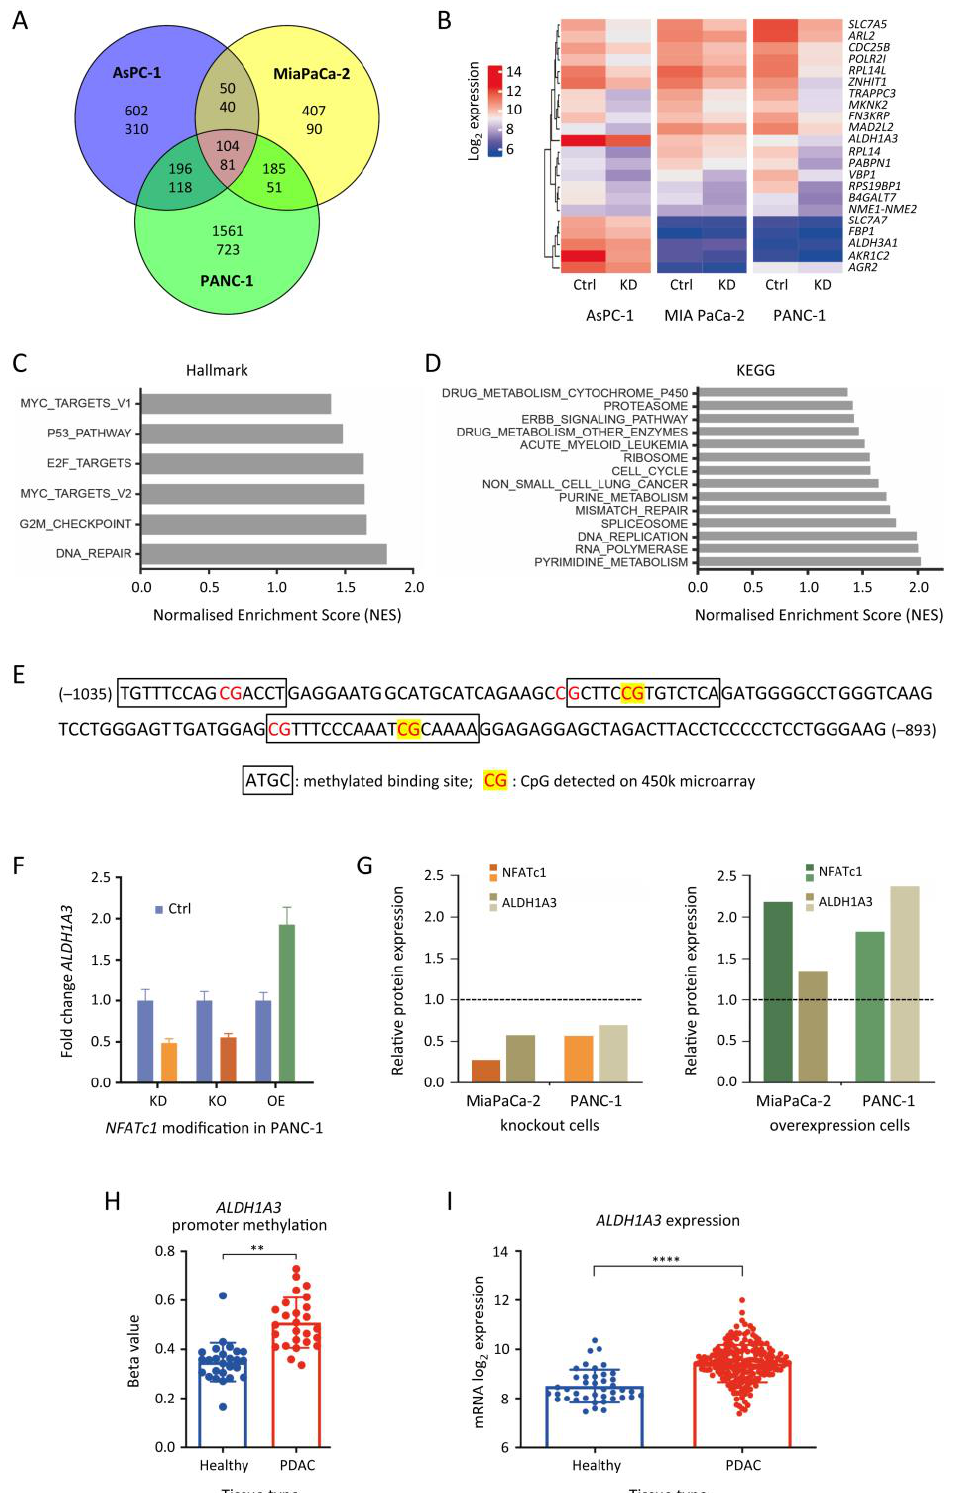
Figure 4. Analysis of NFATc1-based gene regulation. ( A ) Number of genes with significant transcript level variations in three cell lines transfected with NFATc1 siRNA compared to cells transfected with a control siRNA of unspecific, scrambled sequence. The upper and lower numbers give the number of genes with higher or lower transcript levels in the knockdown cells, respectively. ( B ) Heatmap showing the top 24 genes of the total of 81 genes that were consistently downregulated in all three cell lines upon NFATc1 knockdown. Results of a hallmark ( C ) and KEGG gene set enrich- ment analysis ( D ) based on the cell line NFATc1 knockdown transcript profiling. The normalized enrichment score (NES) was used to compare analysis results across gene sets. ( E ) Identification of methylated NFATc1 binding sites in the promoter region of ALDH1A3 using the FIMO tool of The MEME Suit [31]; binding sites are framed; CpG sites are coloured in red. ( F ) Changes in ALDH1A3 expression determined by qPCR upon knockdown (KD), knockout (KO) or overexpression (OE) of the NFATc1 gene in PANC-1. ( G ) The change of ALDH1A3 protein expression upon KO and OE of